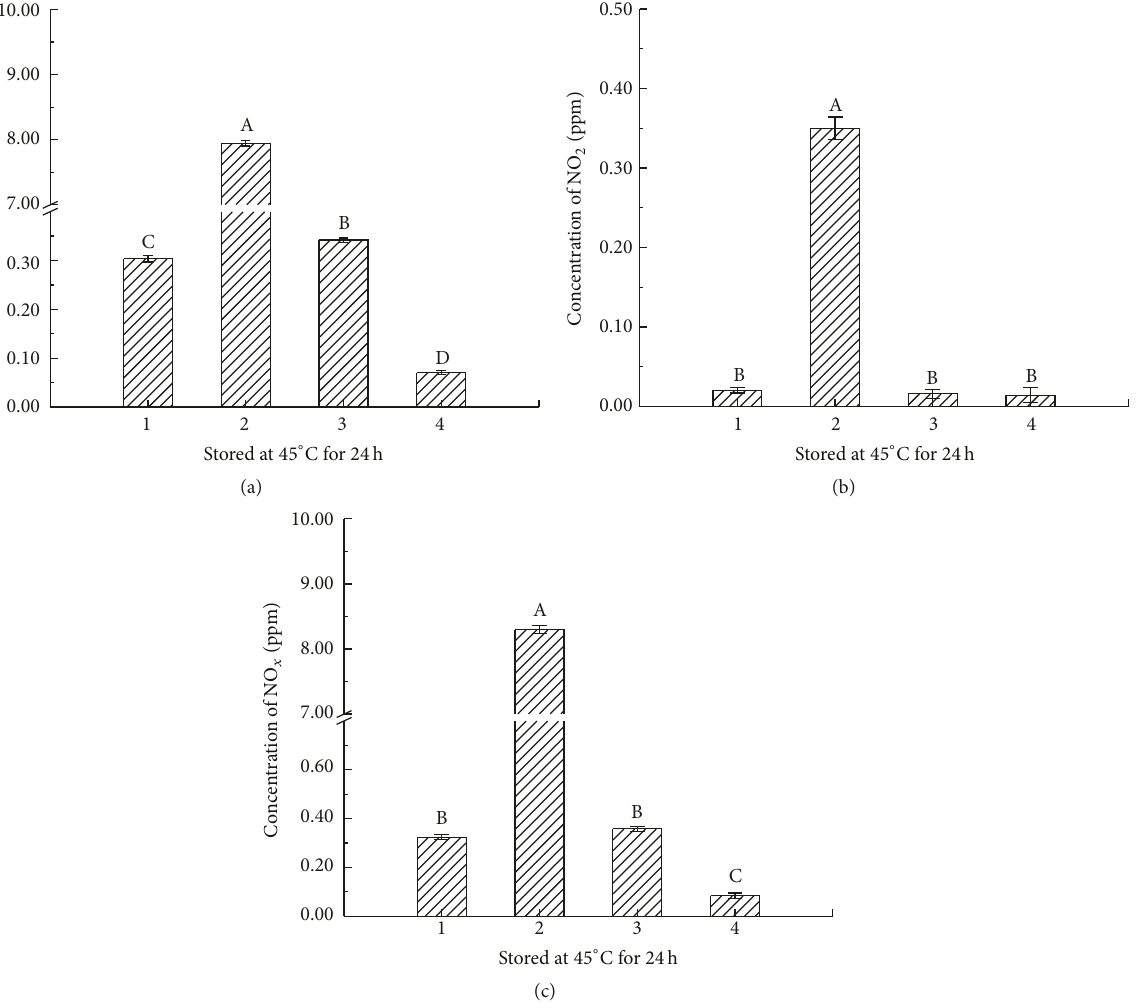
Figure 6: Effect of indirect addition of nitrite and activated carbon (AC) on nitrogen oxides formation in a closed system with flue-cured tobacco. Note . (1) tobacco, (2) tobacco + NaNO 2 , (3) tobacco + NaNO 2 + AC 2.0 g, and (4) tobacco + NaNO 2 + AC 10.0g, 40 g of flue-cured tobacco, and 0.4 g NaNO 2 (266 mg of NO 2− ). The NO 2− , AC, and tobacco were added separately in vacuum desiccators stored at 45 ∘ C for 24 h. Uppercase letters indicate significant differences between the treatments at 𝑃 < 0.05